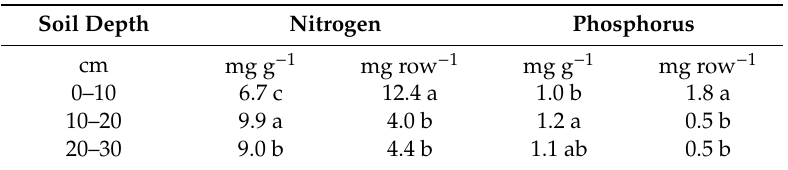
Table 9. Nitrogen and phosphorus concentration and content in the roots of triticale, as a ff ected by the Soil depth mean e ff ect. For each parameter, values followed by the same letter within a column are not significantly di ff erent at P < 0.05, Tukey’s test.